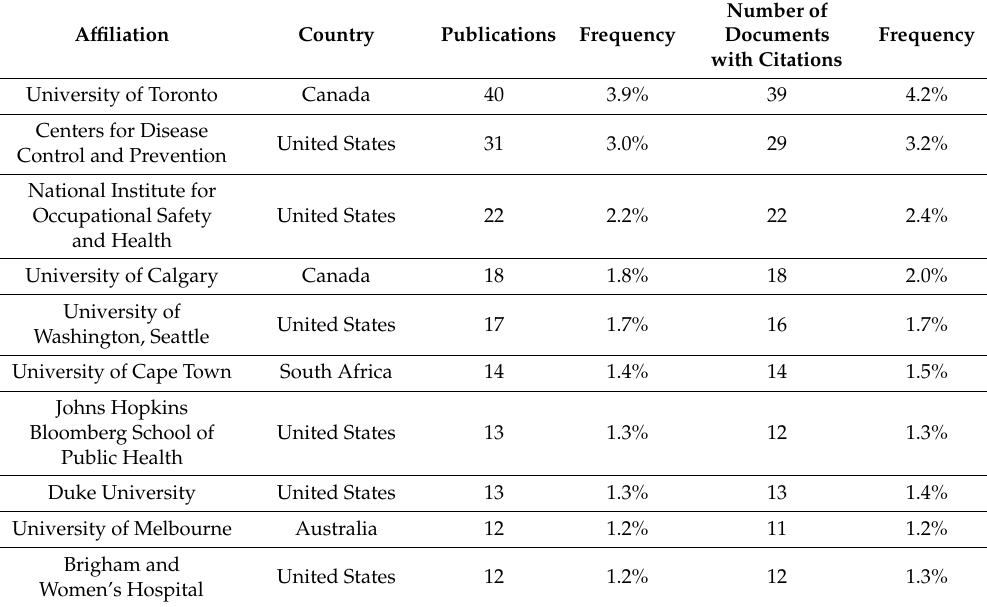
Table 4. Publications and citations by the top ten international institutions.